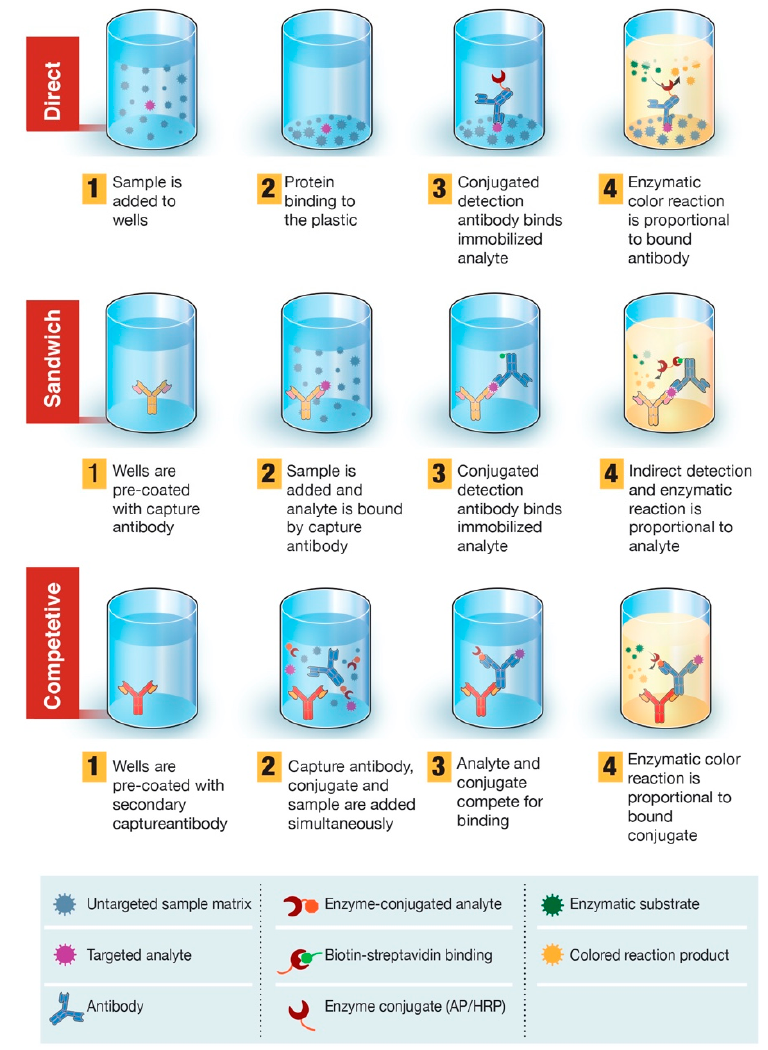
Figure 3. Overview of enzyme-linked immunosorbent assay (ELISA)-based diagnostic test. ELISA can be presented in different formats based on differences in antigen immobilization and antibody labeling. In direct ELISA, SARS-CoV-2 antigen(s) bound to a plastic solid phase is detected by the addition of a conjugated antibody. In sandwich ELISA, the capture antibody is attached to the plastic solid phase. Antigen(s) in the sample will bind to the capture antibody and then be detected by a second enzyme-labeled antibody. In competitive ELISA, sample SARS-CoV-2 antigen is preincubated with the primary antibody and then added to a well coated with a secondary antibody along with an enzyme-conjugated antigen that competes with the sample antigen for binding with the primary antibody. The more SARS-CoV-2 antigen in the sample, the less conjugated antigen will be bound and the lower the signal will be.